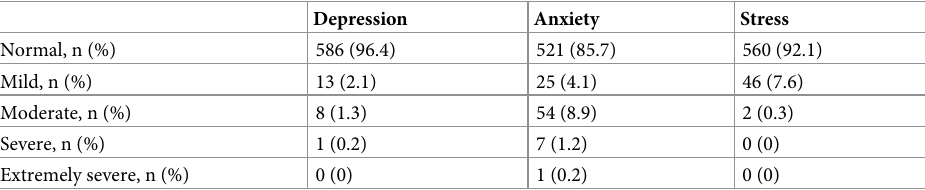
Table 3. Mental health severity symptoms distribution of the study